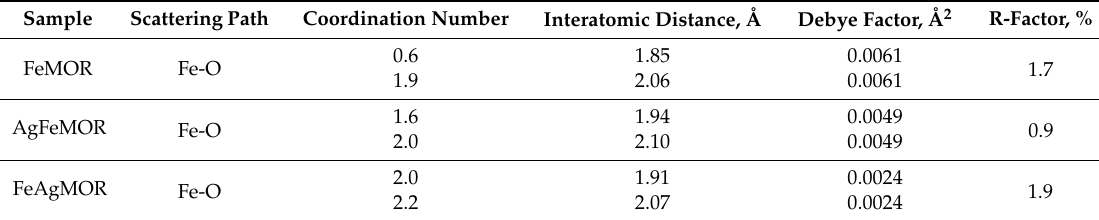
Table 5. Structural parameters obtained from Fe K-edge EXAFS fitting (R-range 1.2 to 2.1 Å, k-range 2 to 12 Å − 1 , kw = 3).